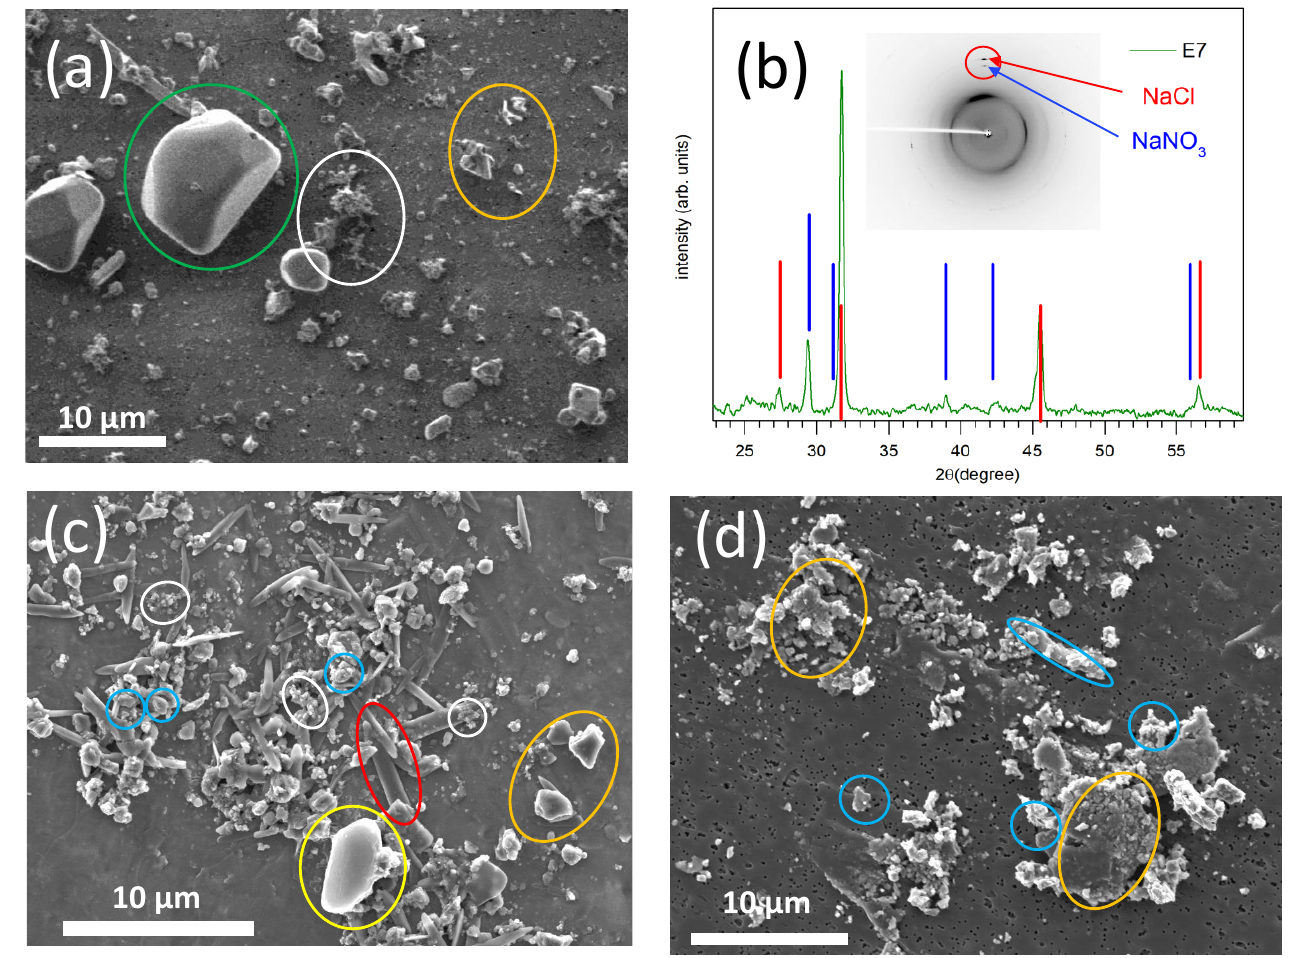
Figure 5 . ( a ) SEM image of stage E7 (D50% = 0.65 µm) of Porquerolles sampling P1 (March 2019); the colored circles indicate different types of particles: NaCl salt (green), soot carbon aggregates (white) and mineral particles (alumina, gypsum, etc.) (orange). ( b ) XRD spectrum of stage E7; the angular positions of the NaCl diffraction lines are indicated by red lines, and those of NaNO 3 in blue. ( c ) SEM image of stage E7 of Porquerolles sampling P2 (July 2019) and ( d ) stage E7 of Le Croisic sampling C4 (July 2020). On ( c ) and ( d ) are circled in the red sulfate-rich particles, in blue the few metallic particles (steel), in white the soot particles, in yellow the carbon particles (microplastics), and in orange the mineral particles (calcium carbonate).